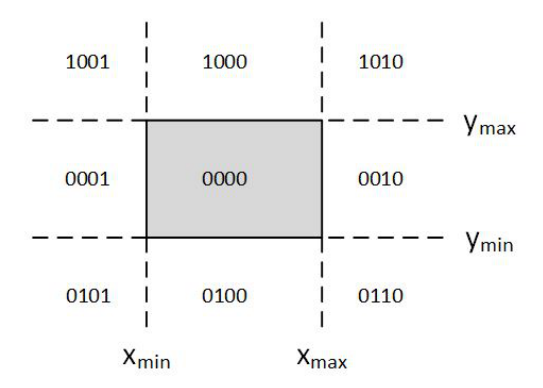
Figure 16. Outcodes for the Midpoint Subdivision algorithm. Starting from the Least Significant Bit (LSB), each bit represents one region; left, right, bottom, top (see Figure 17). If a line endpoint is inside that region then the corresponding bit is set to true (1) or otherwise false (0).